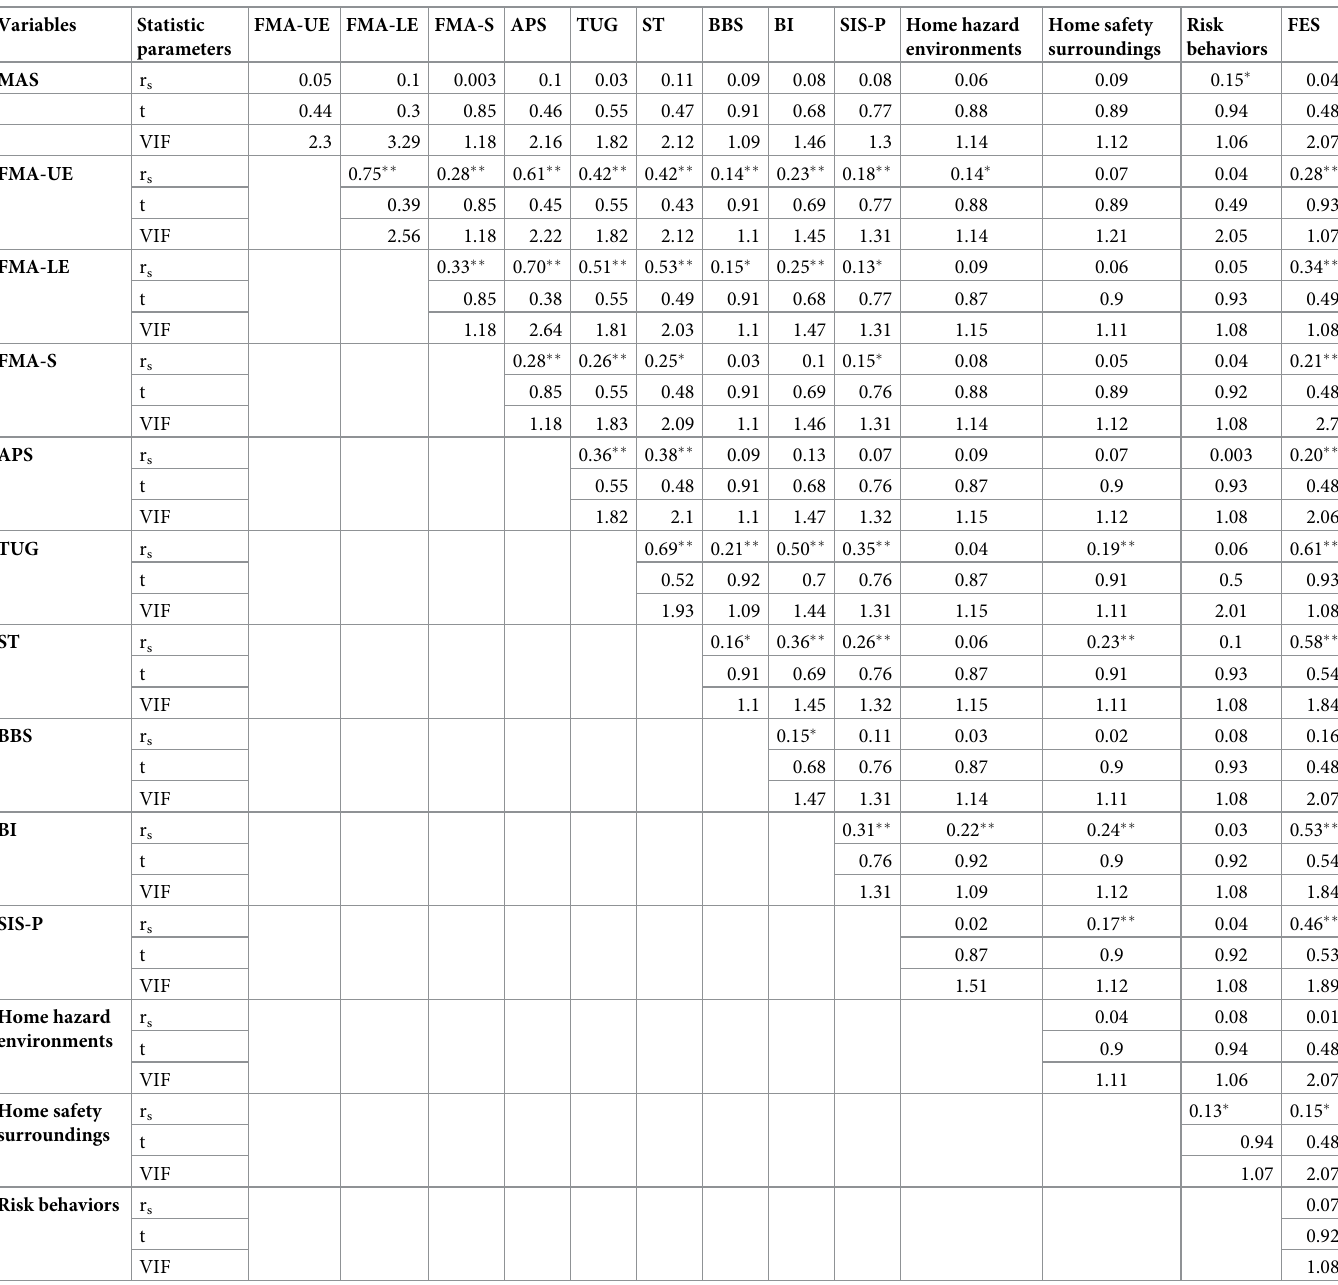
Table 2. Correlation coefficient (r s ), tolerance (t), and variance inflation factor (VIF) values of a pair of measure variables.